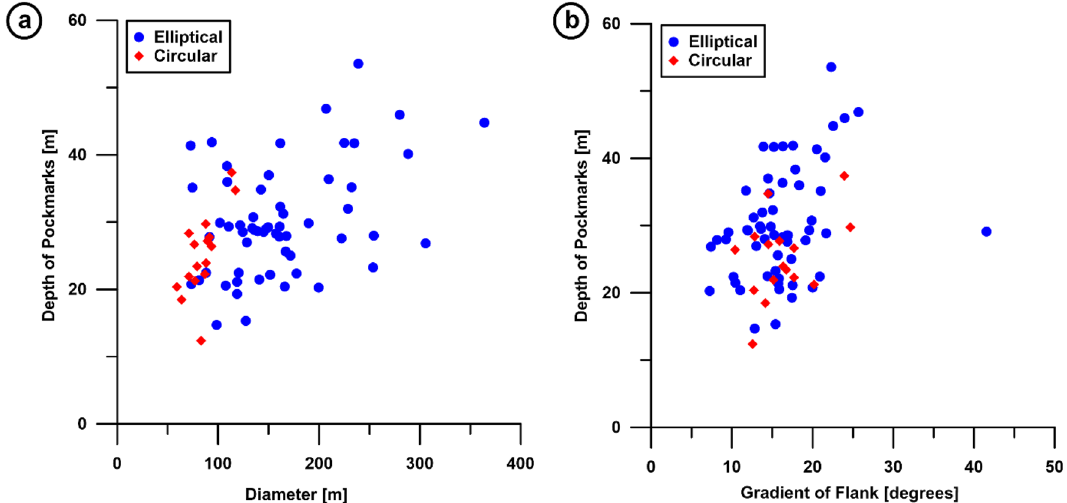
Figure 5. ( a ) Morphometric plot showing the depth of the pockmarks versus their diameter (n = 59 for elliptical pockmarks and n = 16 for circular pockmarks); ( b ) Morphometric plot showing the depth of the pockmarks versus gradient of their flanks (n = 59 for elliptical pockmarks and n = 16 for circular